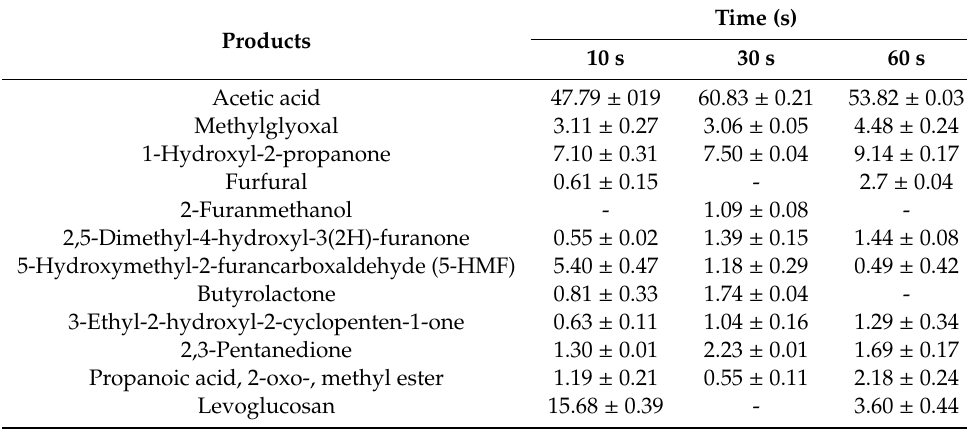
Table 3. The peak areas (%) of the typical products derived from the glucose in situ catalytic pyrolysis with a glucose / KAc ratio of 1:0.25 at 350 ◦ C for 10 s, 30 s and 60 s.